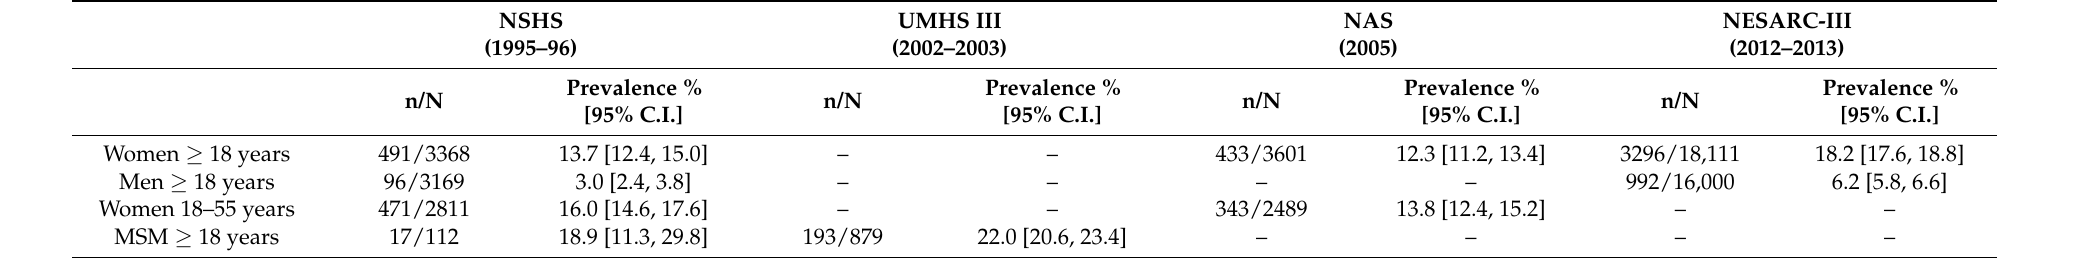
Table 6. CST prevalence trends among U.S. adults and high-risk sub-populations (1995–2013) †